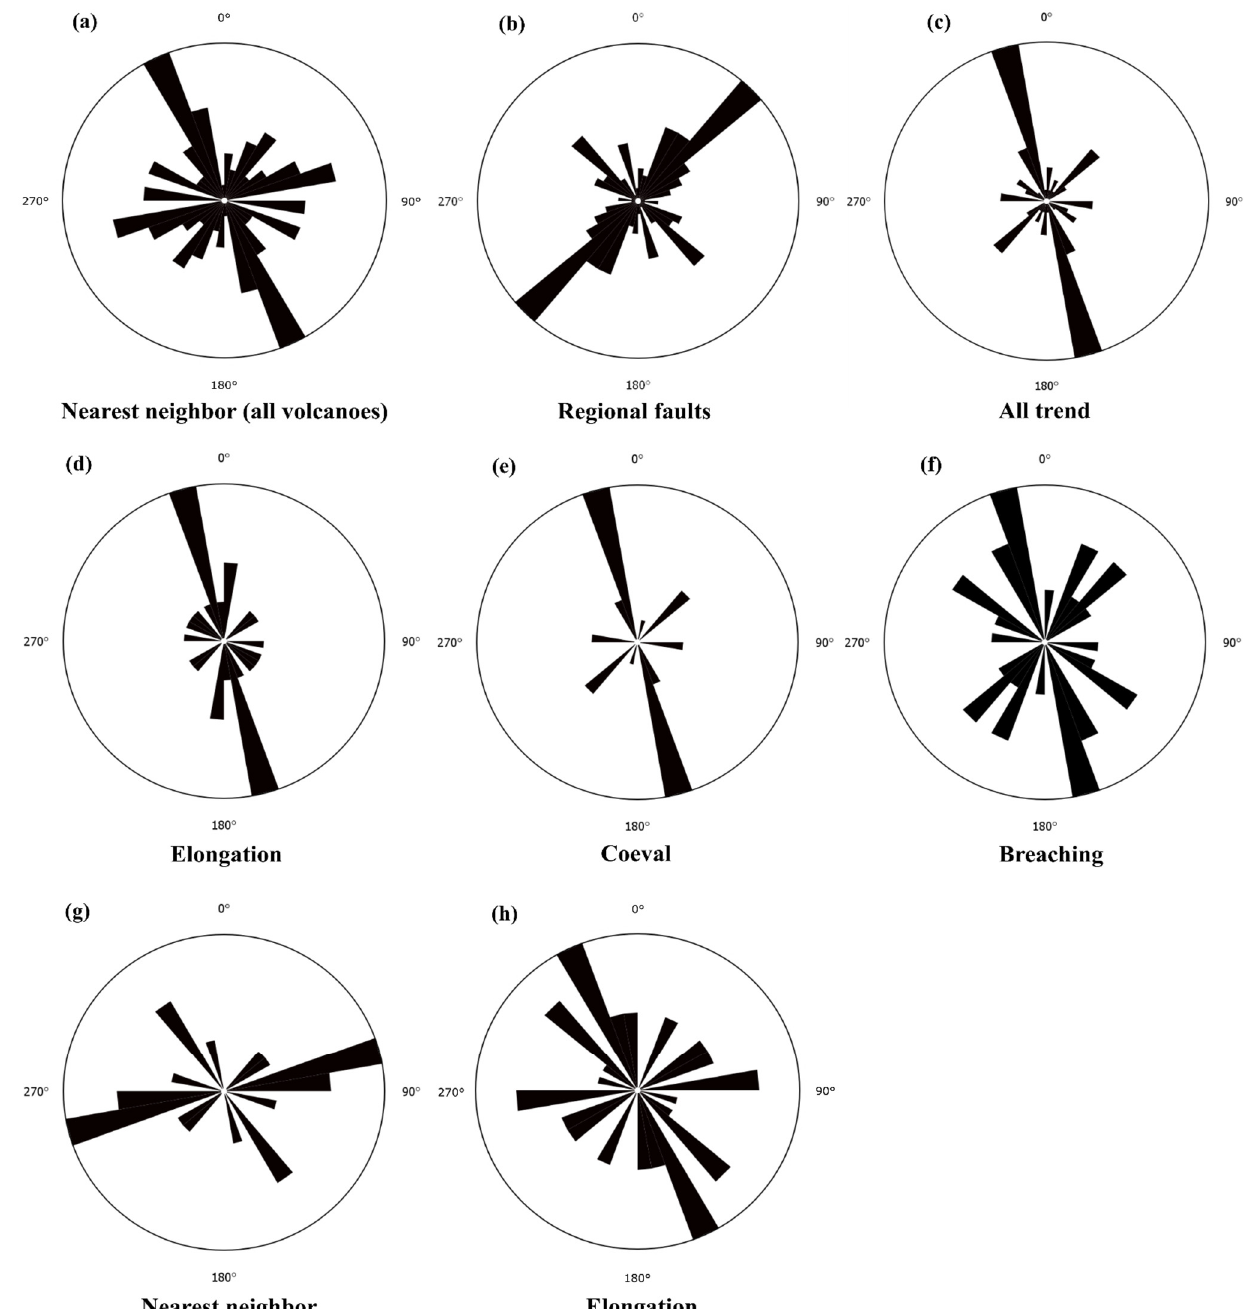
Figure 8. Rose diagrams related to the trend of: ( a ) alignment trend of all volcanoes (cones and maars) in the MAVF, resulting from the nearest neighbour method; ( b ) fault lines from a regional view; ( c ) all of the trend data measured in this study for scoria cones; ( d ) maximum crater elongation axis for scoria cones; ( e ) coeval cone crater alignment for scoria cones; ( f ) breaching bisector azimuth for scoria cones; ( g ) alignment trend of all maars, resulting from the nearest neighbour method; ( h ) maximum crater elongation axis for maars.